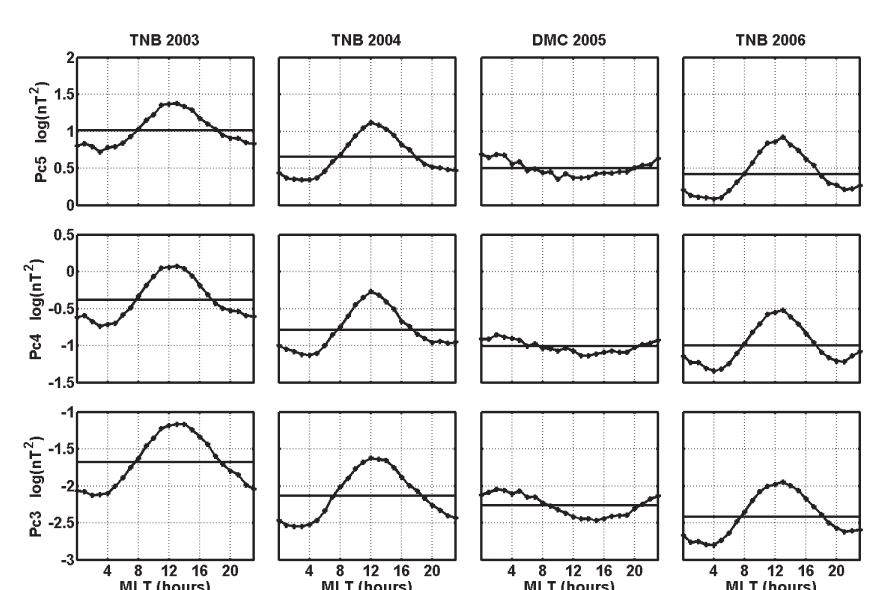
Fig. 1. MLT variation of the hourly power of the horizontal component at TNB and DMC stations through the years. From top to bottom: Pc5 (1-7 mHz), Pc4 (7-22 mHz), Pc3 (22-100 mHz)